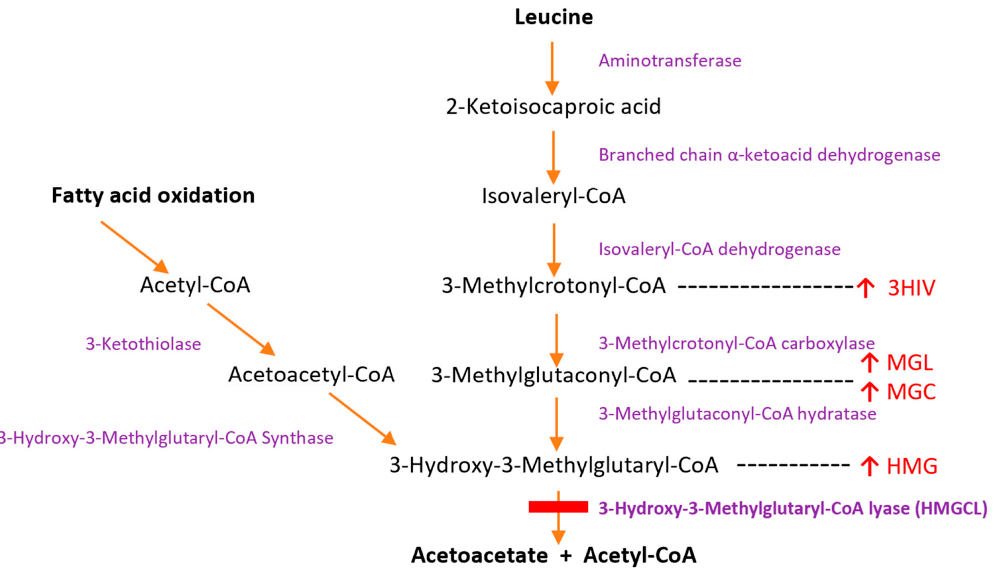
Figure 1. Graphical illustration of the various enzymes and metabolites involved in leucine catabolism and ketone body synthesis. HMG-CoA Lyase is the enzyme involved in the final step of mitochondrial ketone body production from both fatty acid oxidation and leucine catabolism. Reduced or absent function of this enzyme causes accumulation of HMG (3-hydroxy-3-methylglutyrate), MGC (3-methylglutaconate), MGL (3-methylglutarate), and 3HIV (3-hydroxyisovalerate) in bodily fluids.